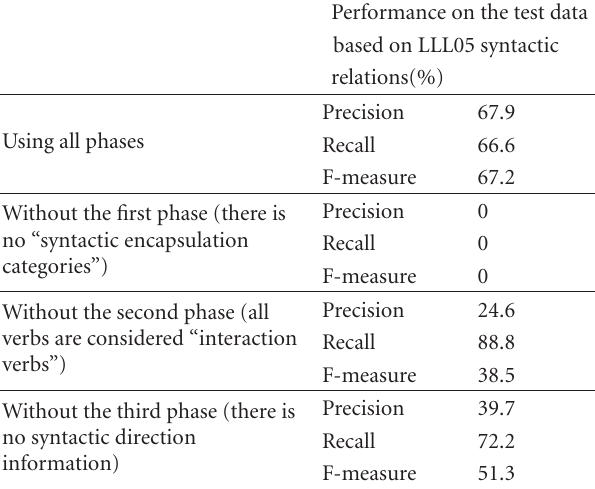
Table 5: Change in performance when one phase is